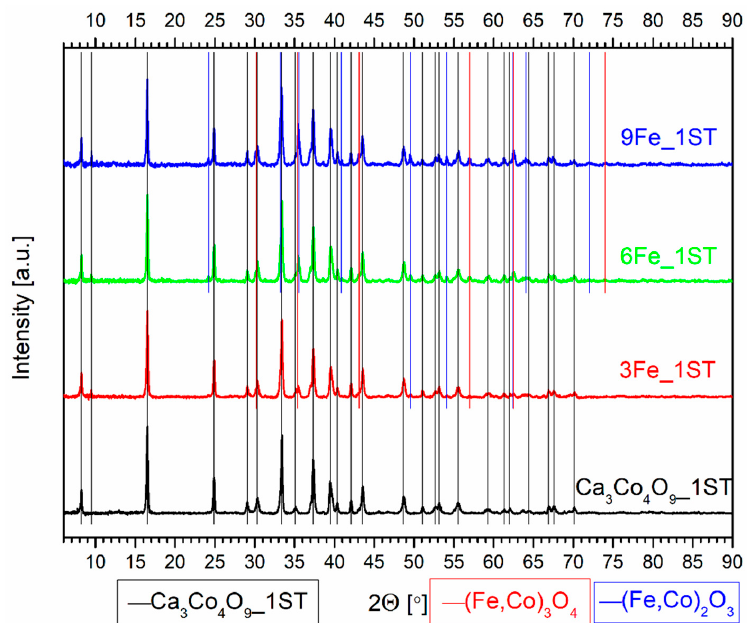
Figure 1. Normalized XRD patterns of the 1ST sintered reference matrix and Fe added samples. The vertical lines of different colors mark the main identified phases.